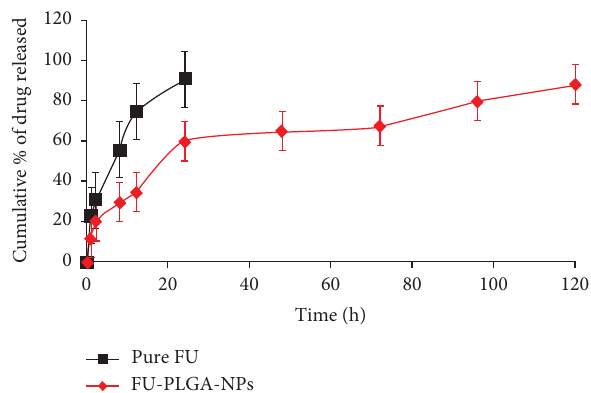
Figure 4: Te cumulative FU in vitro releases from FU-PLGA-NPs